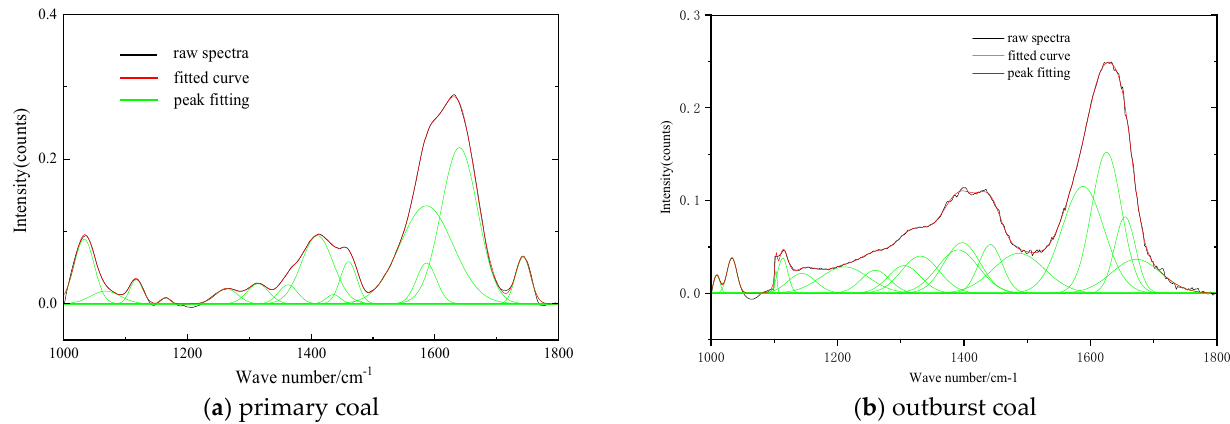
Figure 5. FTIR Spectra of Oxygen Functional Group Structure.